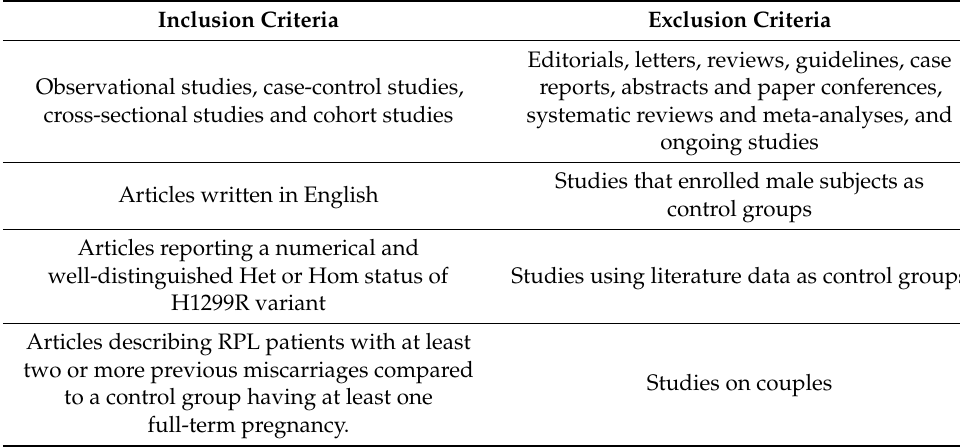
Table 1. Description of inclusion and exclusion